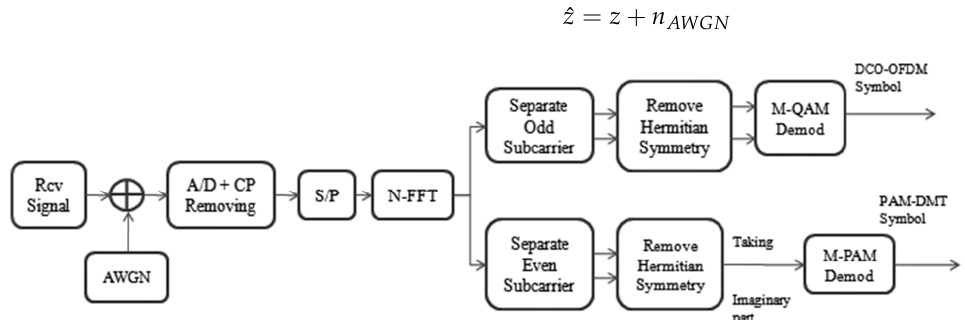
Figure 1. DC-biased pulse amplitude modulated orthogonal frequency division multiplexing (DPO-OFDM) transmission side where dc-biased optical OFDM (DCO-OFDM) and pulse amplitude modulated discrete multitone (PAM-DMT) elec- trical signals are formed and then combined and converted to the optical domain. Note that QAM stands for quadrature amplitude modulation; while IFFT, S/P, P/S, CP and D/A stand for inverse fast Fourier transform, serial-to-parallel, paral- lel-to-serial, cyclic prefix, and digital-to-analog, respectively.